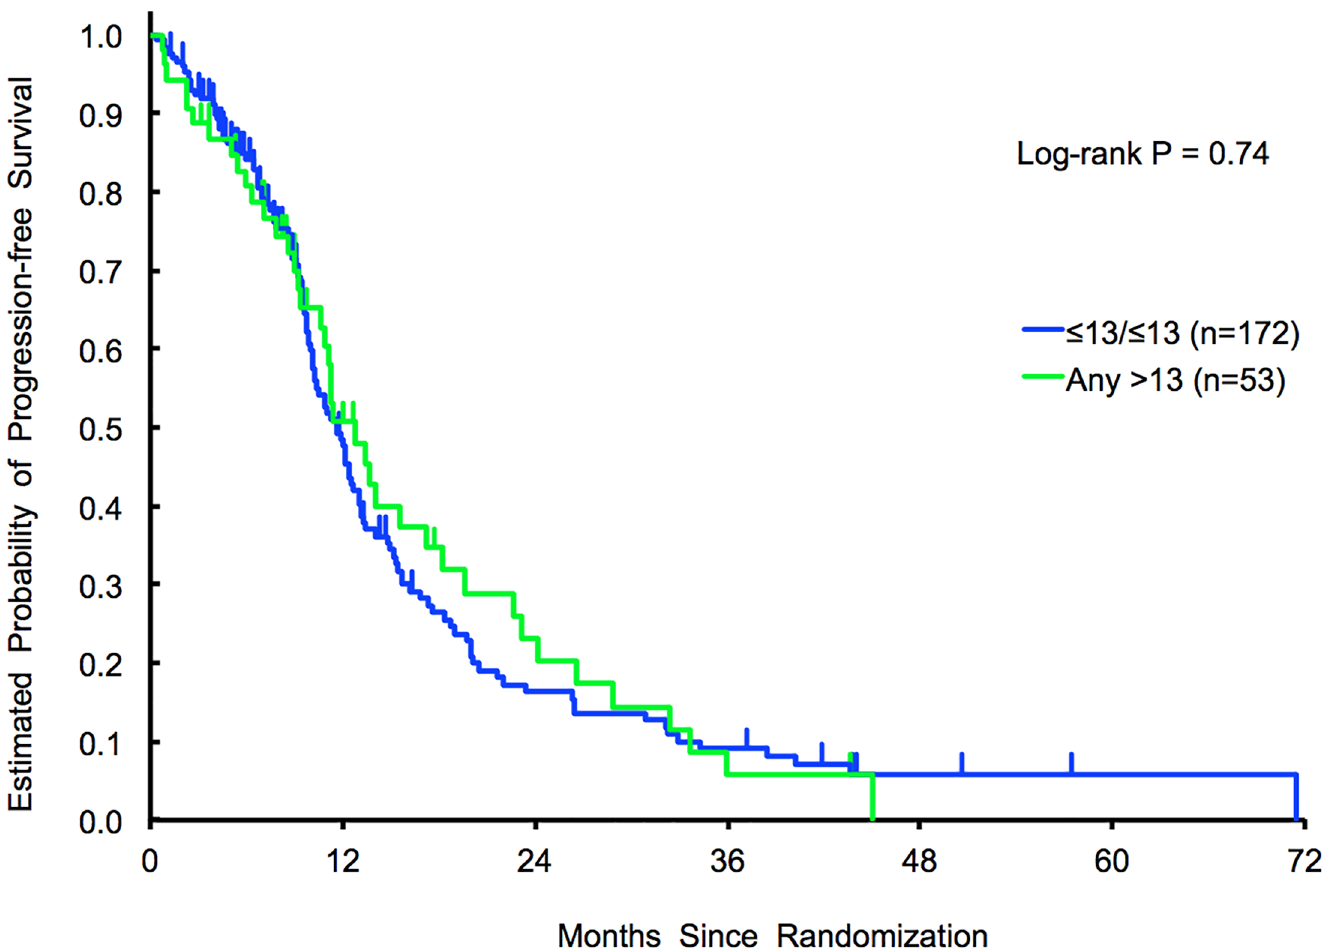
Fig 2. Exploratory cohort 2 (tribe—B). PFS results in any > 13 repeats vs (cid:20) 13/ (cid:20) 13 repeats . Genotyping results. Associations between CCTTT repeats and outcomes in validation cohort 1 are summarized in Table 3.